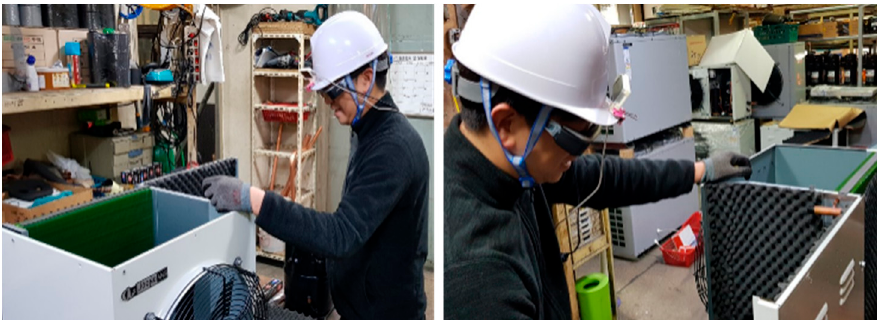
Figure 23. Industrial workers were experiencing task assistance through AR smart glasses.